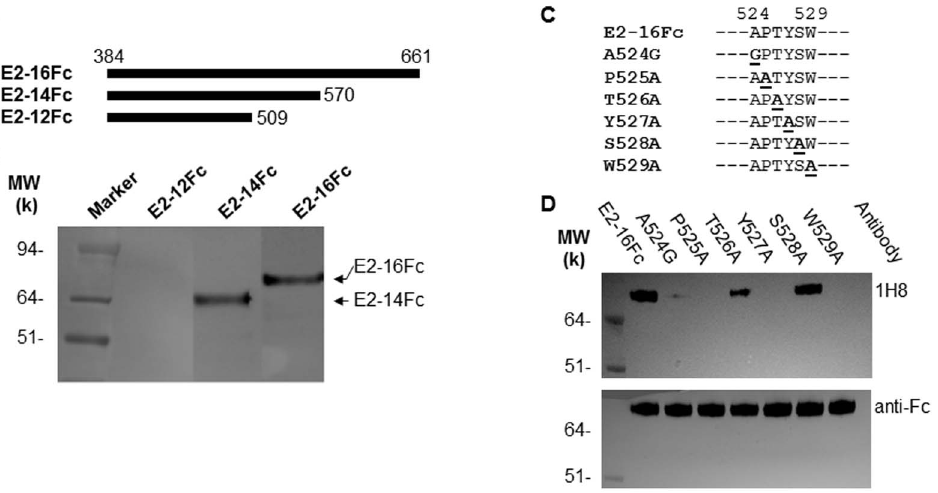
Figure 3. Effect of truncation and mutation of HCV E2 protein on the binding to 1H8. (A) A schematic diagram of the wild-type HCV E2 protein (based on the H77 strain sequence) and its truncated forms that were used in this study. (B) A Western blot analysis was performed to determine the reactivity of mAb 1H8 with the proteins indicated. The secreted forms of these E2 proteins were produced after transient transfection of Huh7 cells. For the Western blots, 1H8 (1:1000 dilution) and an HRP-conjugated anti-mouse IgG (1:3000 dilution) were used as the primary and secondary antibodies, respectively. (C) Site-directed mutagenesis of the E2-16Fc construct was performed to determine the key residues for the binding of 1H8. The residues at positions 525, 526, 527, 528 and 529 were replaced by alanine one at a time. At position 524, the alanine was replaced by a glycine. A hyphen indicates an amino acid that is identical to that of the H77 strain sequence. (D) Western blot was performed by using 1H8 (top panel) versus anti-human IgG1 Fc (bottom panel) to determine the effect of the mutations on the binding of 1H8.